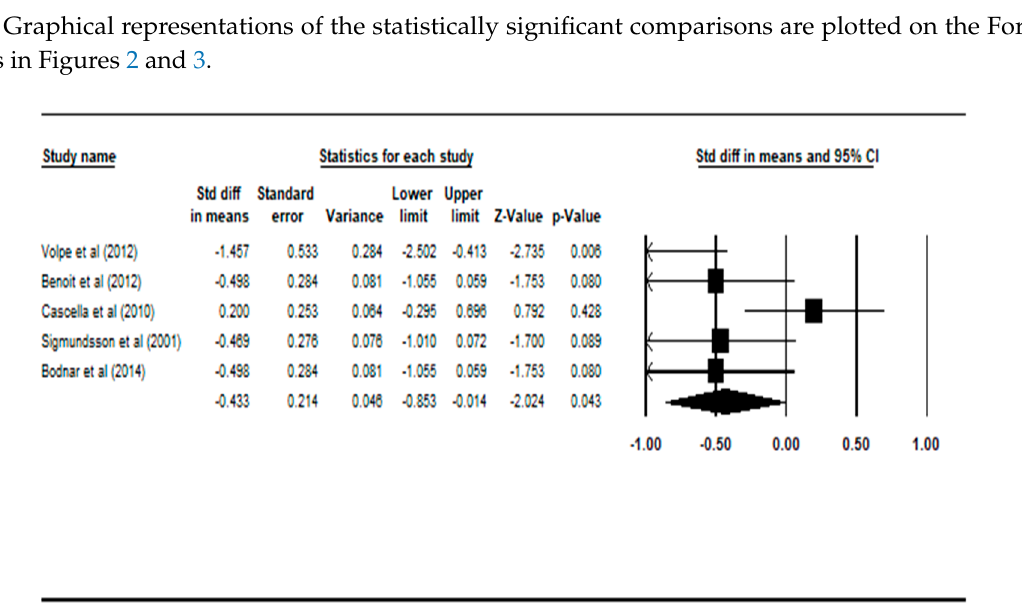
Figure 2. Forest plot: DS vs. HC, grey matter volume. Abbreviations: Std diff, standard difference; CI, confidence interval.